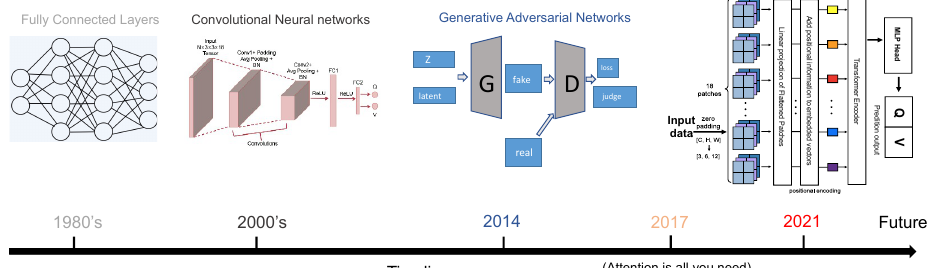
Figure 1. ( a ) structure of the L3 PC nanocavity, constituting a candidate for a typical semiconductor laser. Overall size of the device is around 100 microns in length and 200 nm in thickness. The 54 air holes in the center box will be converted into a 2-D pixel array as the input tensor. Inset at the bottom right: resonant TE mode solved by FDTD simulation. ( b ) evolution of DL models, spanning from the 1980 to the present time. Chronologically, DNNs have gradually evolved from the earliest MLP to CNN, then to Generative Adversarial Networks (GAN), and finally to the latest ViT based on self-attention. ViT has been a disruptive force in CV and image classification etc. since